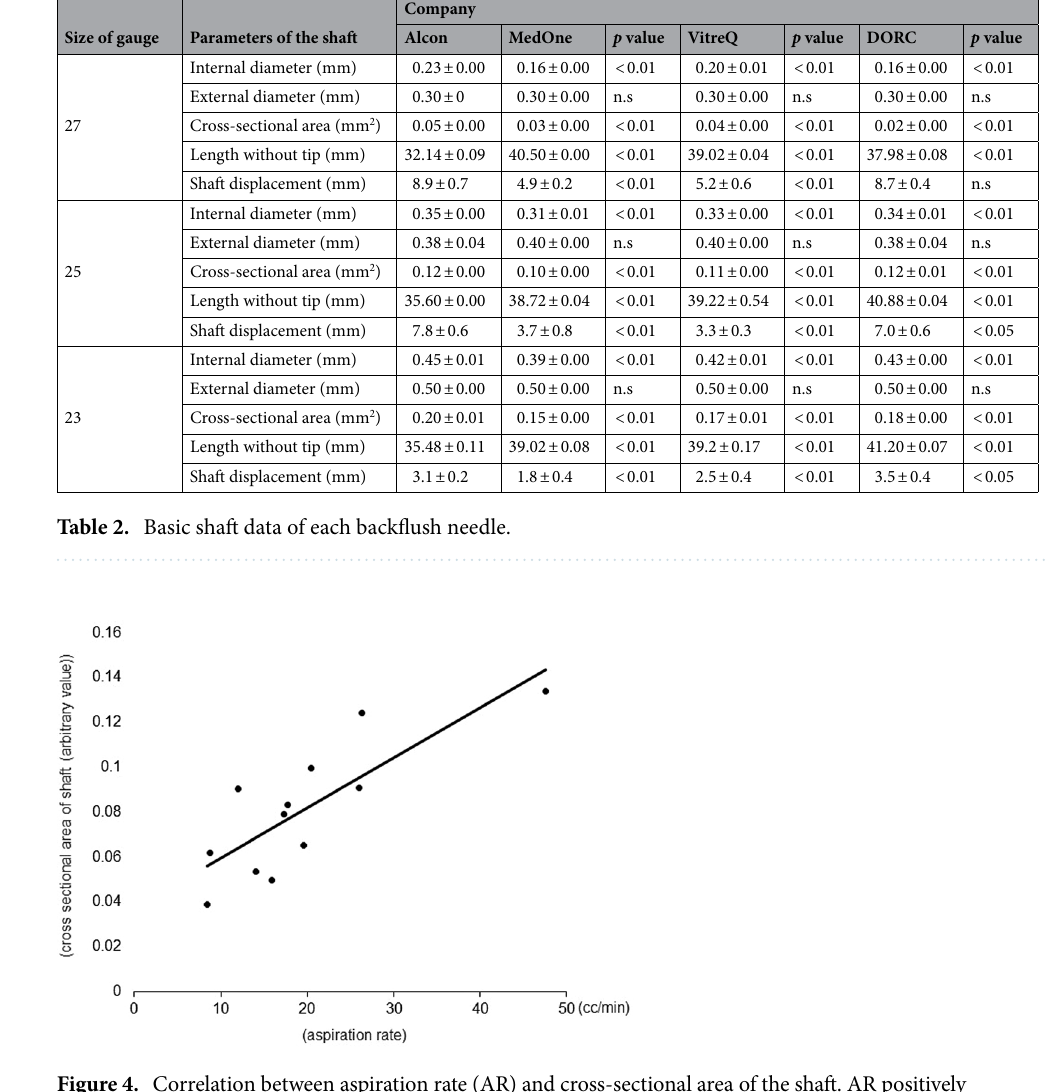
Figure 4. Correlation between aspiration rate (AR) and cross-sectional area of the shaft. AR positively correlated with cross-sectional area of the shaft ( r 2 = 0.75, p = 0.0002).